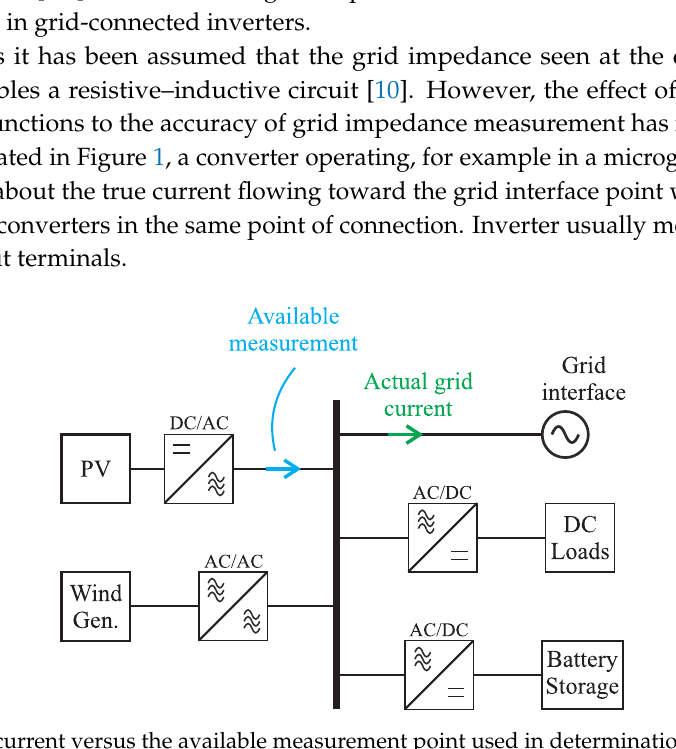
Figure 1. True grid current versus the available measurement point used in determination of grid